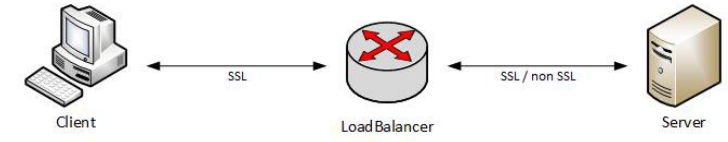
Figure 10. Mode HTTP—SSL Termination.